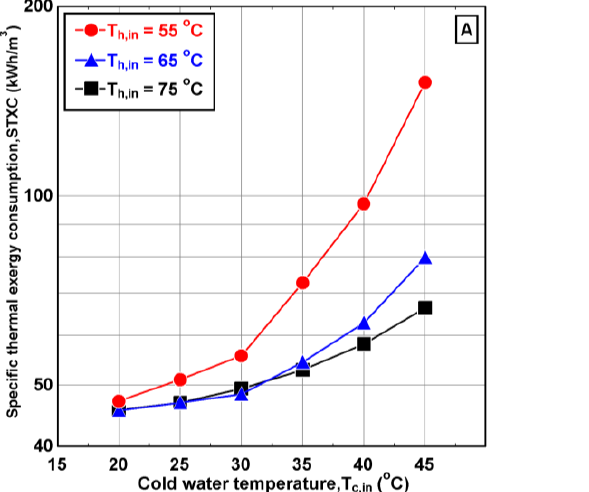
. . V h = 840 L/h, V c = 405 L/h,